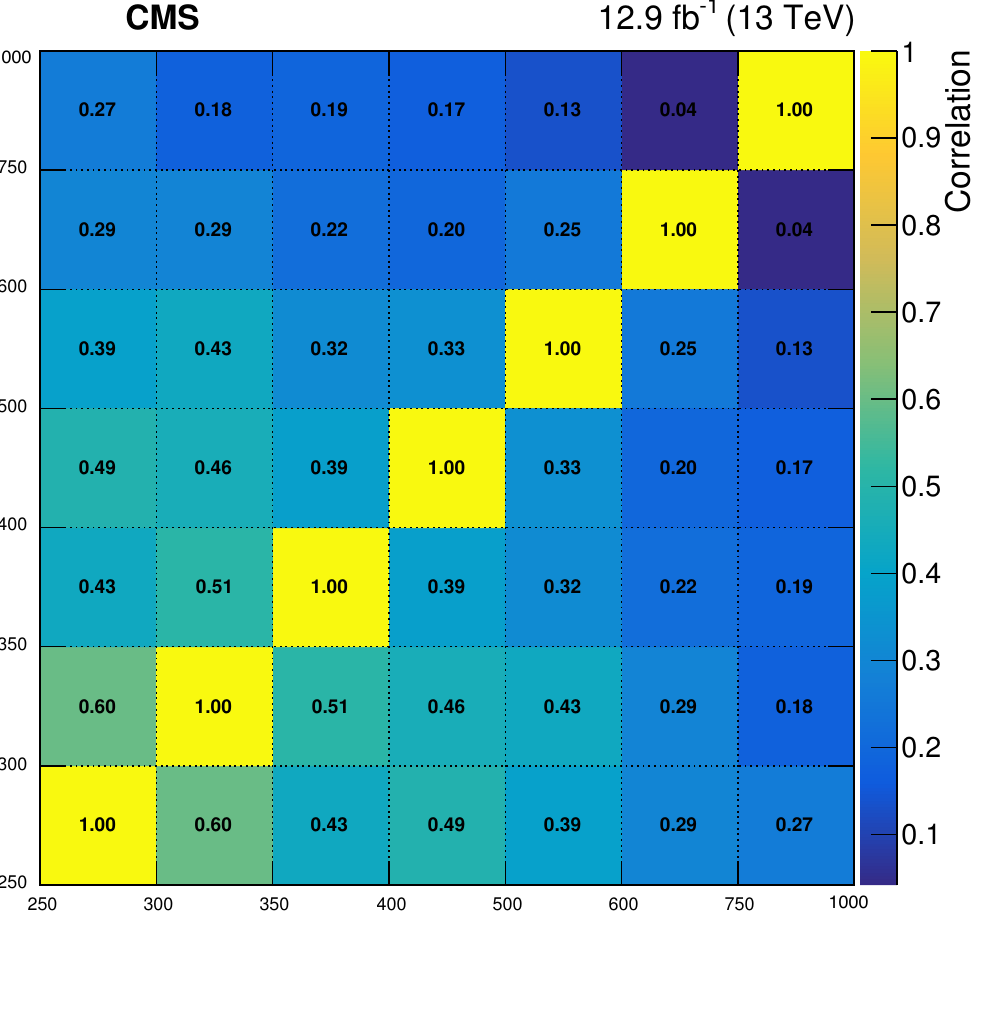
bins, expressed in GeV, are T